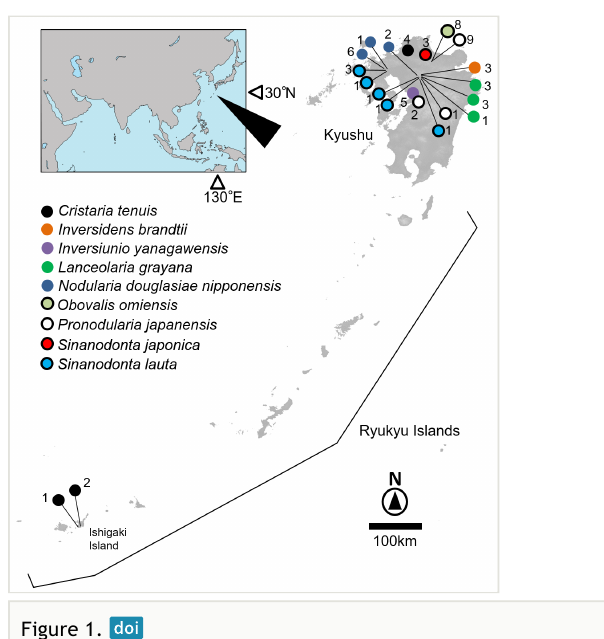
Figure 1. Sampling sites of the nine freshwater mussel species in the Kyushu and Ryukyu Islands. The number attached to each circle indicates the number of individuals.